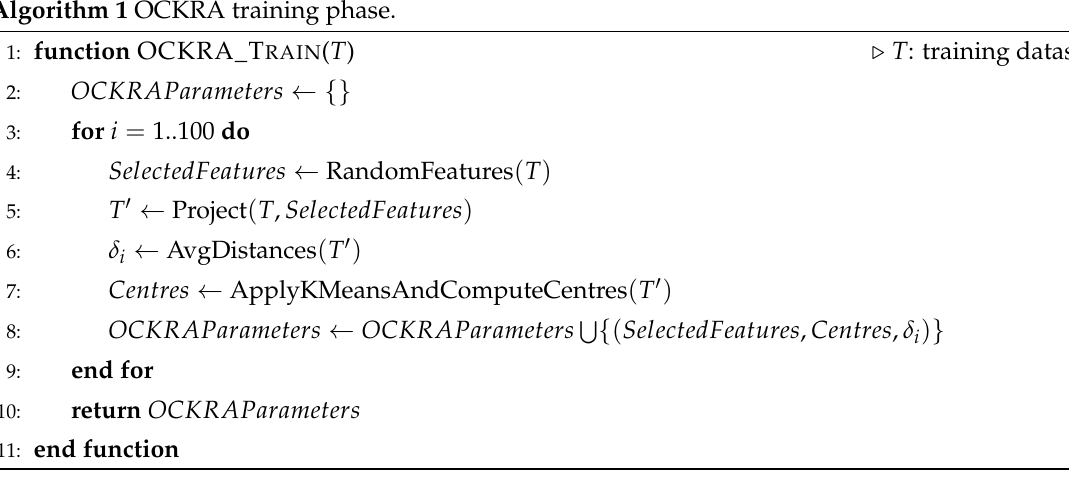
Algorithm 1 OCKRA training